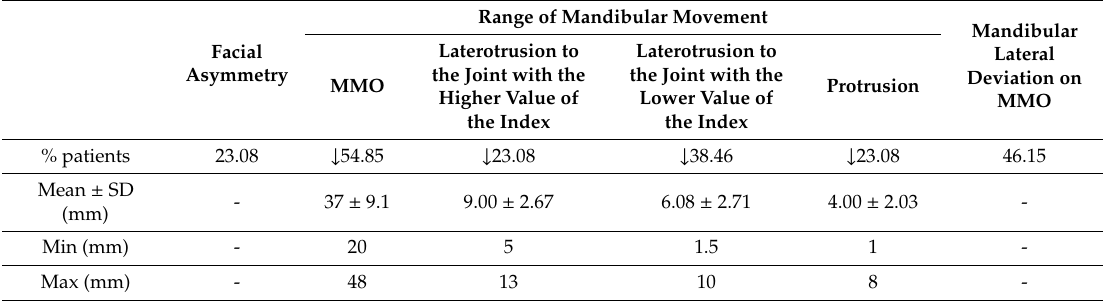
Mandibular Lateral Laterotrusion to